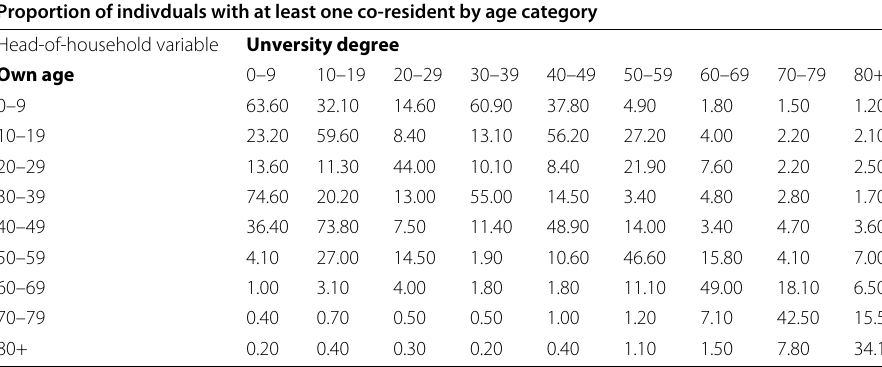
Table 11 Proportion of individuals with at least one co-resident by age and head-of-household education level ( Continued )